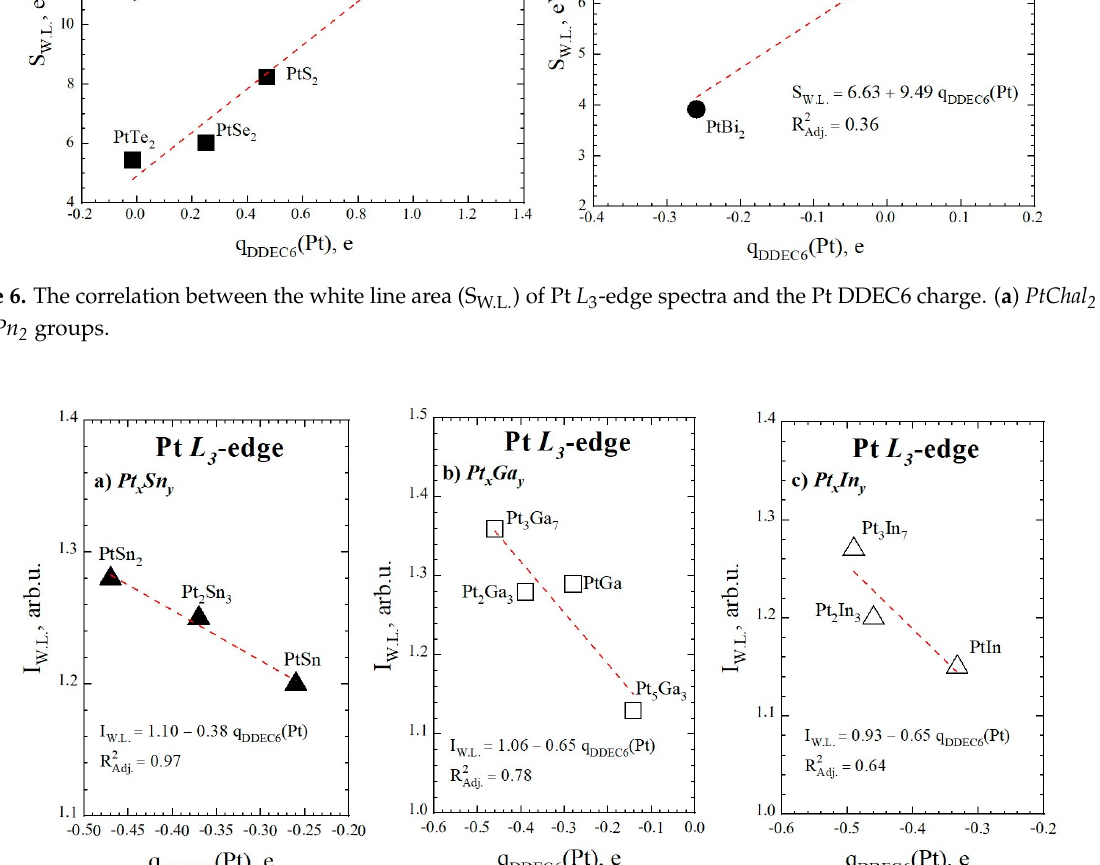
Figure 7. The correlation between the white line intensity (I W.L. ) of Pt L 3 -edge spectra and the Pt DDEC6 charge. ( a ) Pt x Sn y , ( b ) Pt x Ga y , and ( c ) Pt x In y groups.